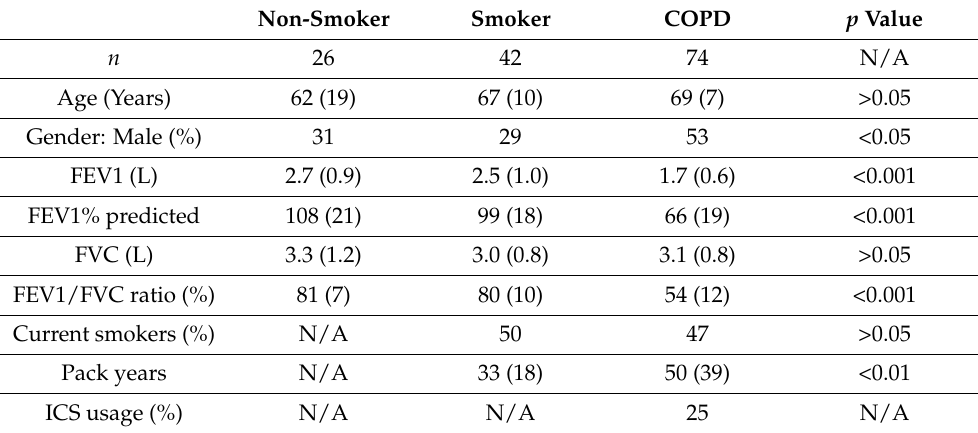
Table 1. Patient demographics for all patients in the study. Kruskal–Wallis multiple comparisons test was used to test differences between